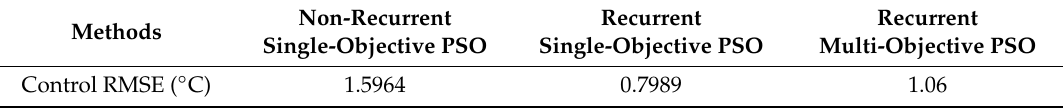
Table 5. Optimized controller parameters of recurrent single-objective